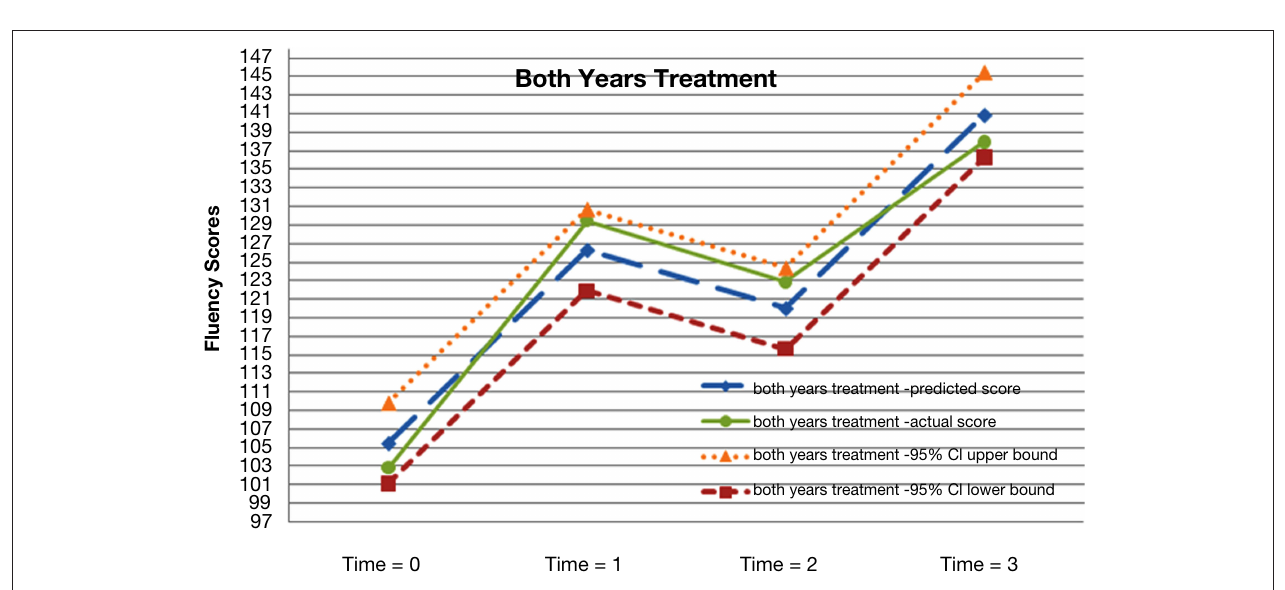
Figure 4 | Actual and predicted growth trajectories for students who received the treatment during year-2 as well as 95% confidence intervals around the predicted growth trajectories.